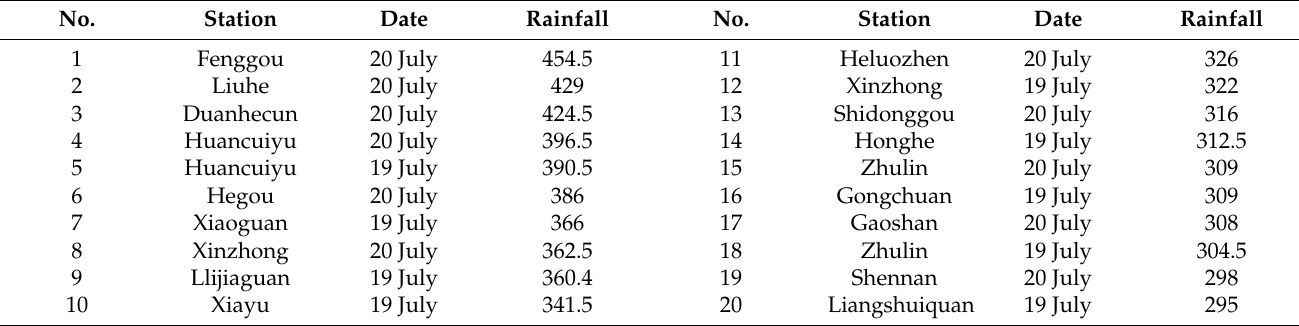
Table 1. The top 20 daily rainfall events